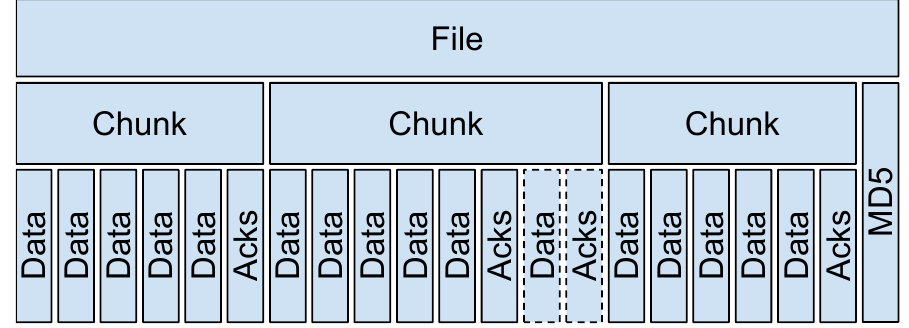
Figure 8. The XBee Transfer Protocol breaks a file into chunks with batched acknowledgments per chunk. Lost data packets are retransmitted (dotted lines) until all data fragments in each chunk